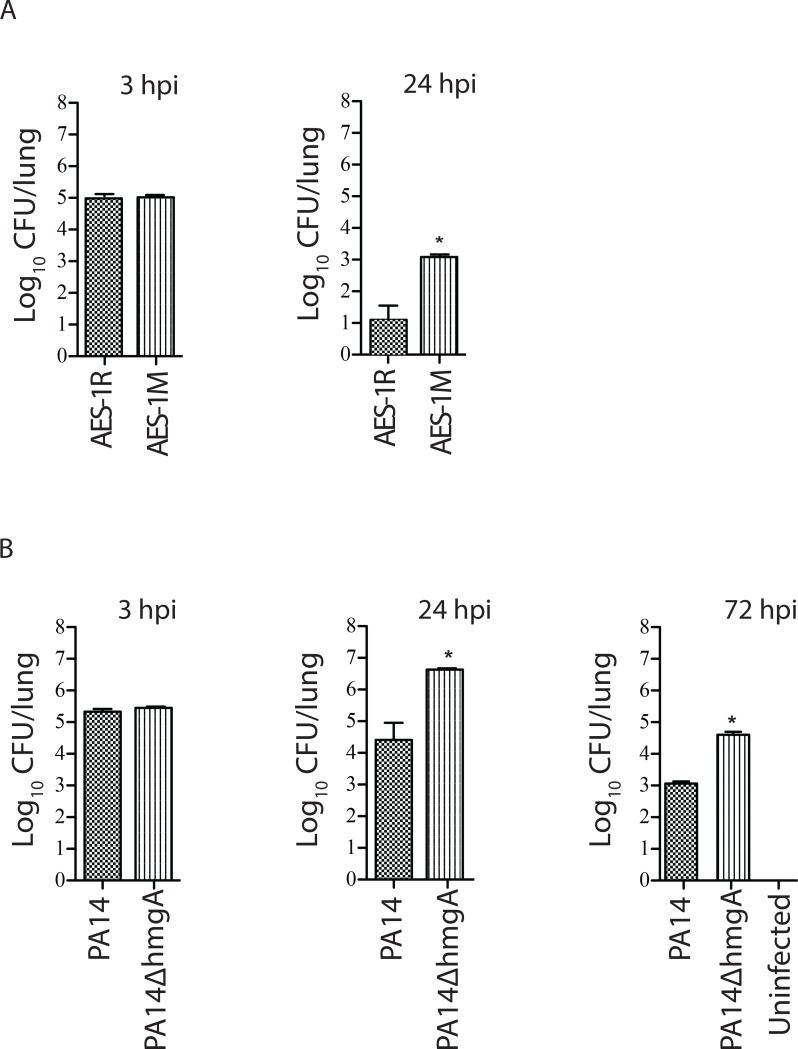
Persistence of P. aeruginosa AES-1R, AES-1M and PA14, PA14hmgA, in a C57BL/6 mouse model.
A. Mice were infected with 106 CFU of AES-1R and AES-1M and lungs examined at 3-hrs and 24-hrs and 72hrs post-infection for bacterial load (latter not shown). B. Mice were infected with 106 CFU wildtype PA14 and PA14hmgA and lungs were examined at 3-hrs, 24-hrs, and 72-hrs post-infection for bacterial load. AES-1M was recovered at significantly higher level compared to AES-1R at 24-hr. PA14ΔhmgA was recovered at a significantly higher level compared to the wild type PA14 at 24- and 72-hrs post-infection. The significances of differences between strains were determined by ANOVA. 4A: *p<0.001vs AES-1R; 4B* p<0.0001 vs. PA14 WT.